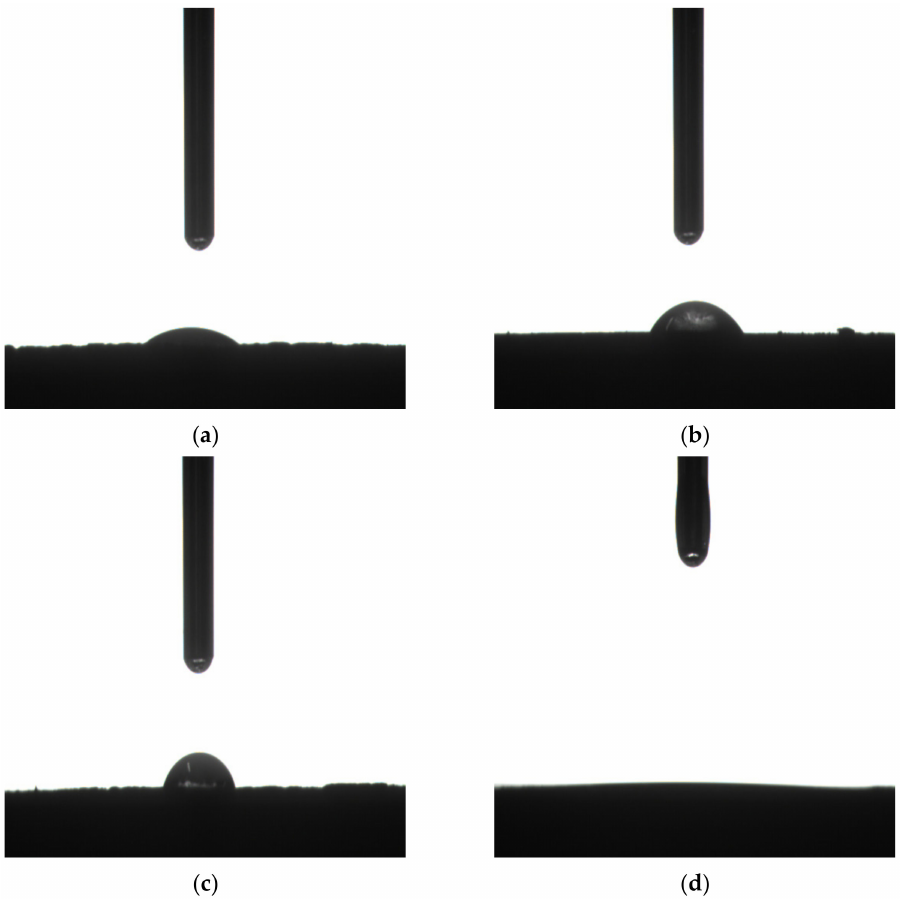
Figure 3. Contact angles of water droplets on the surface of the catalyst: ( a ) [C 2 (MIM) 2 ]PW 12 O 40 ; ( b ) [C 4 (MIM) 2 ]PW 12 O 40 and ( c ) [C 6 (MIM) 2 ]PW 12 O 40 . Contact angles of n-octane droplets on the surface of the catalyst: ( d ) [C 2 (MIM) 2 ]PW 12 O 40 . Table 3. Comparison of different catalysts for removal of dibenzothiophene (DBT) in model fuel. Catalyst Reaction Conditions S-Removal (%)